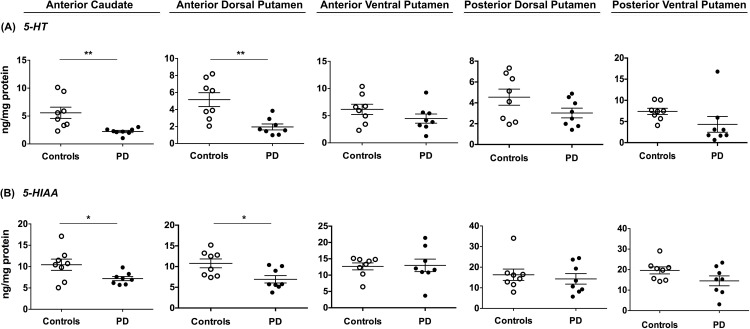
Serotonergic metabolism in Parkinson’s disease patients and age-matched controls.Levels of serotonin (A) and its metabolite, 5-HIAA (B) were measured by HPLC in the anterior caudate nucleus and different sub-regions of the putamen in control subjects (o, n = 8) and patients with PD (•, n = 8). All regions analyzed showed serotonin and 5-HIAA data overlap between control and PD groups and were only significantly reduced in the anterior dorsal putamen and the anterior caudate nucleus. Scattered plots depict mean ± SEM for each cohort and differences were analyzed between groups by unpaired, two-tailed t-test. *: p ≤ 0.05; **: p ≤ 0.01, ***: p ≤ 0.001.